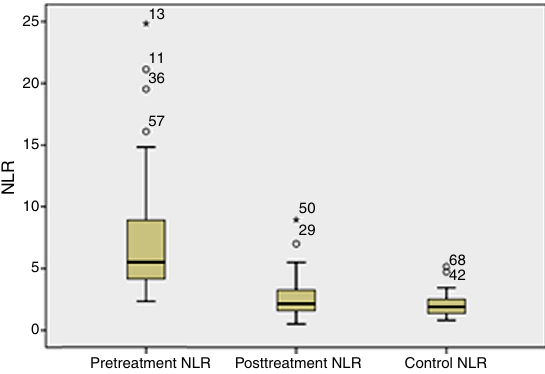
Figure 2 NLR values in the PTA pretreatment and post- treatment groups and the control